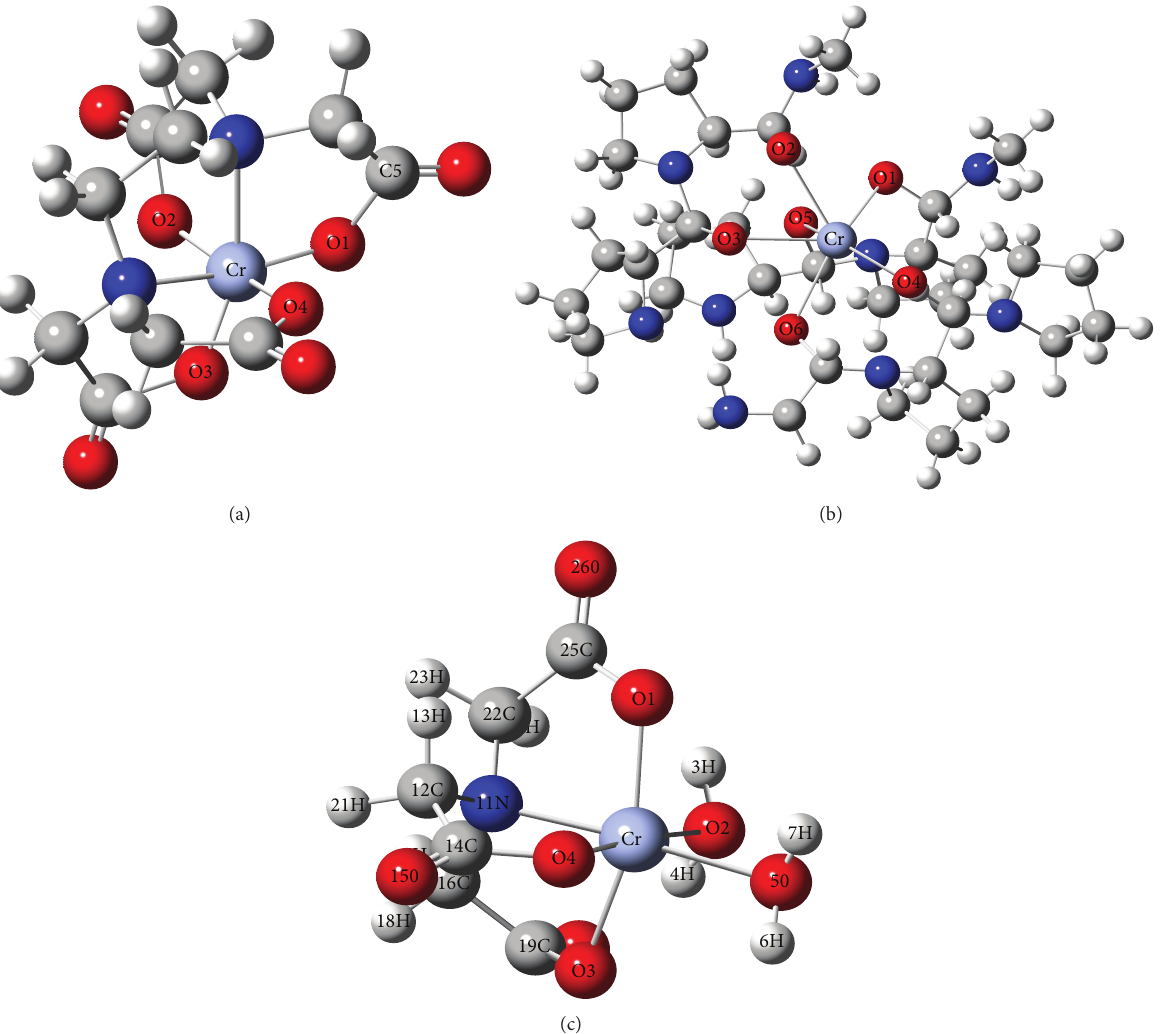
Figure 5: Structures of the isomer “B” of the Cr-EDTA complex (a), Cr-collagen complex (b), and Cr-NTA complex (c).